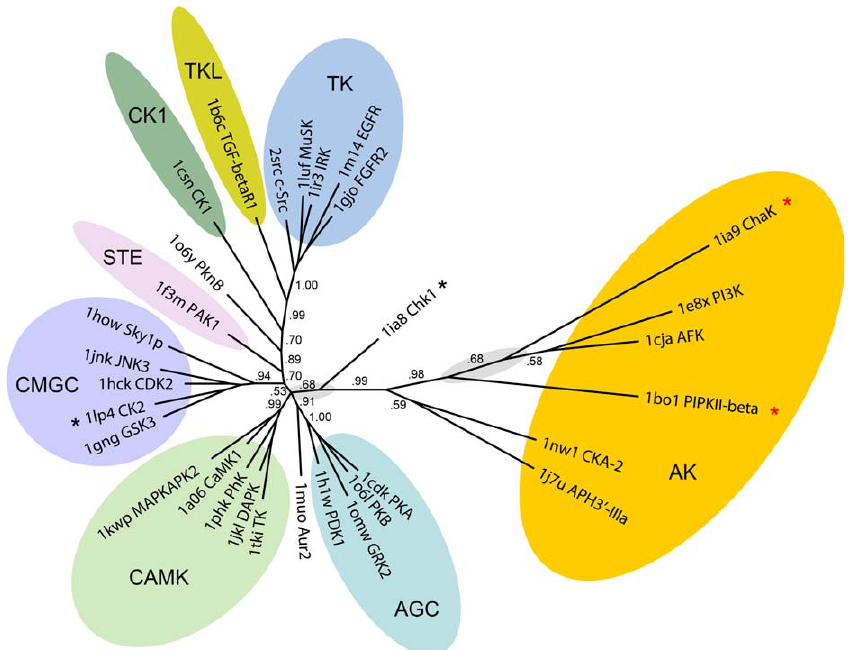
Figure 4. Proposed Phylogeny for the Kinase-Like Superfamily, Based on a Unified Bayesian Analysis of Both the Sequence Alignment in Figure 3 and the Structural Character Matrix in Table 2 Structures are labeled by their PDB IDs, followed by the abbreviated name of the structure. TPKs are to the left of the figure, and are labeled with their group membership. TPKs labeled with a black asterisk are classified differently in our tree compared with the classification produced by Manning et al . [7]. The AKs are highlighted with an orange oval. Major branches are labeled with their posterior probabilities. Gray ovals represent areas of doubt in the tree, based on the tree itself and other aspects of our analysis (see text). The left-hand oval represents uncertainty as to the closest TPK relative to the AKs; it is unclear where precisely the AKs should link to the TPKs (note that this uncertainty does not include the branching of most of the TPK groups in this region, as these are generally well supported). The right-hand oval represents uncertainty as to the proper placement of ChaK and PIPKII b . These kinases are difficult to place with high confidence because of their extreme divergence. They are labeled with red asterisks to denote the speculative nature of the current placement (see text). DOI: